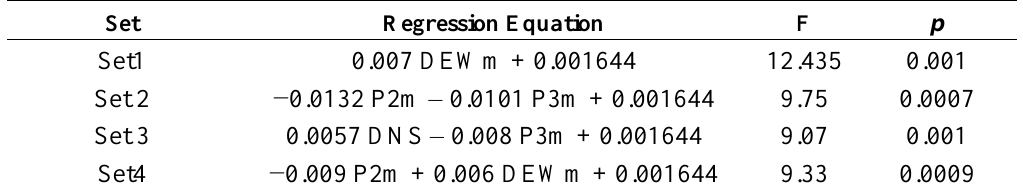
Table 4. Linear regression equations derived from each set of predictors using the forward stepwise